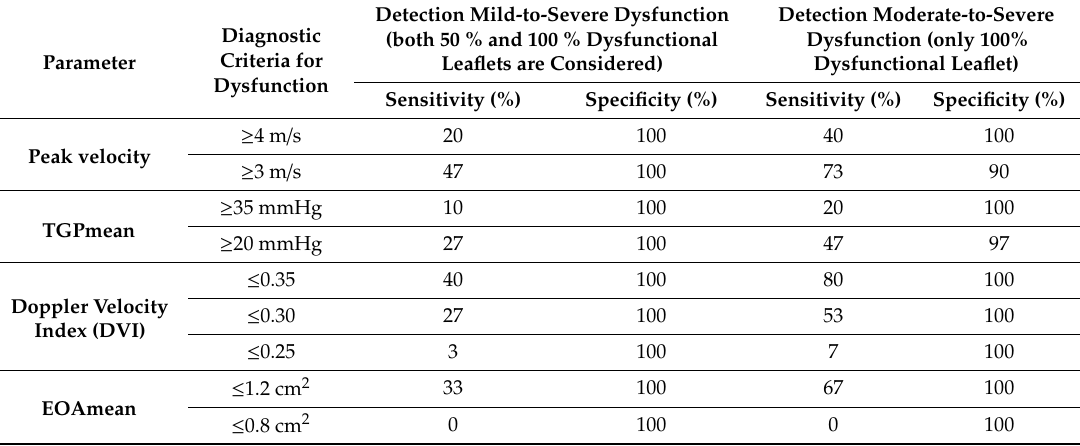
Table 2. Sensitivity and specificity of Doppler parameters for all cases (with and without LVOT